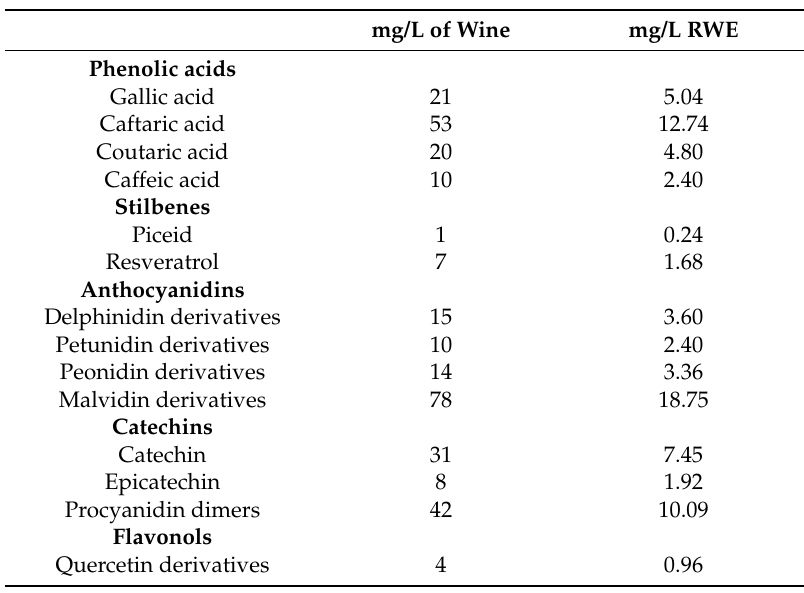
Table 1. Composition of the red wine extract (RWE) obtained from the 2012 Santenay 1er cru Les Gravi è